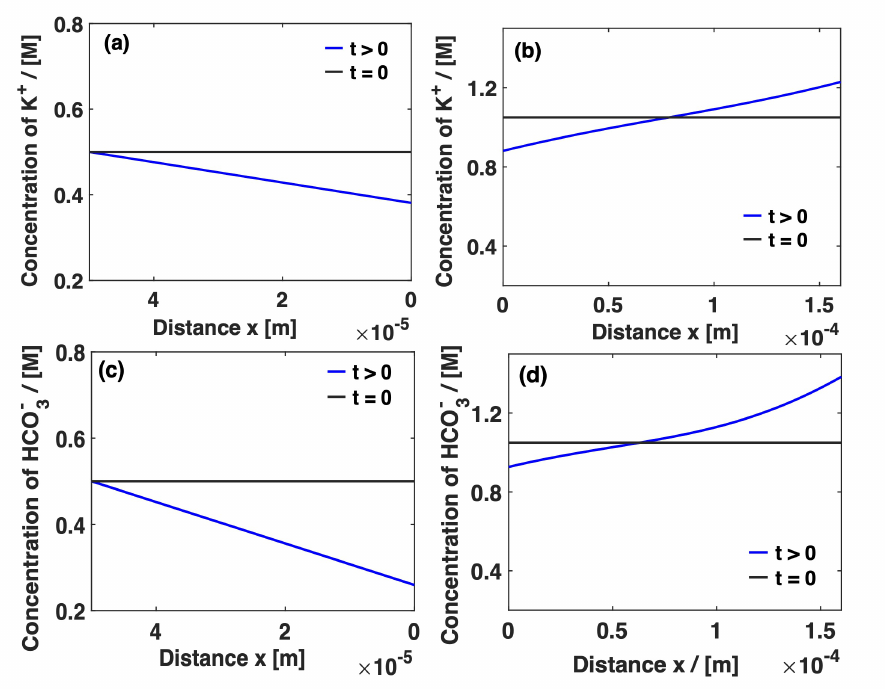
Figure 6. The transport of the ionic species through the diffusion layer (depleted side) and the bulk of the membrane at t = 0 (black line) and t > 0 (blue line). ( a ) the steady state concentration of K + at the depleted side of the CEM (blue line) and ( b ) inside the bulk of CEM (blue line); ( c ) the steady state concentration of HCO − at the depleted side of the AEM (blue line) and the concentration change of 3 HCO − inside the bulk of AEM (( d ), blue line). The equal concentration of 0.5 M KHCO 3 is assumed 3 for catholyte and anolyte, respectively. The thickness of the bulk membrane is 160 µ m, and the diffusion layer thickness on either side of the membrane is 50 µ